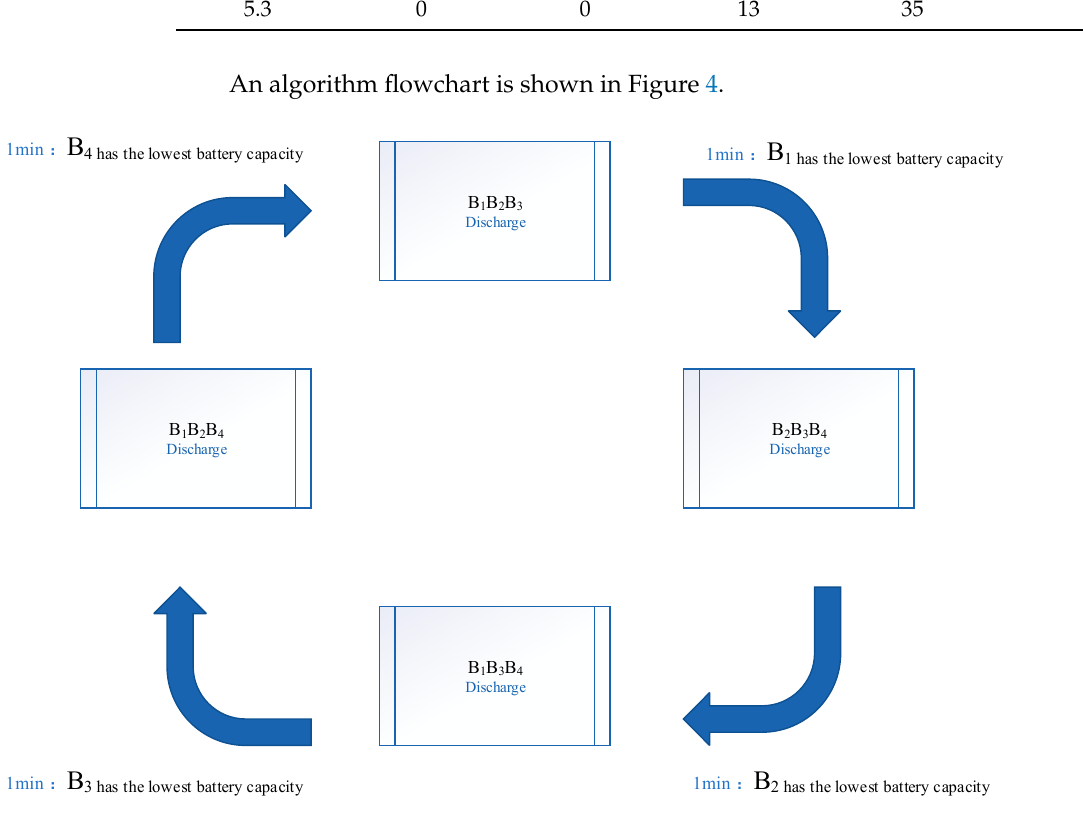
Figure 4. Algorithm fl ow